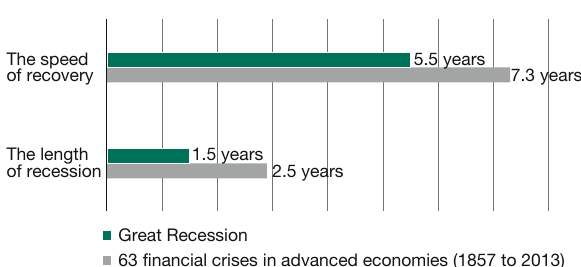
Recovery: Great Recession in a historical perspective